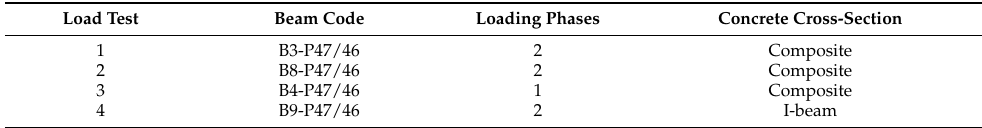
Table 1. Load test protocol.